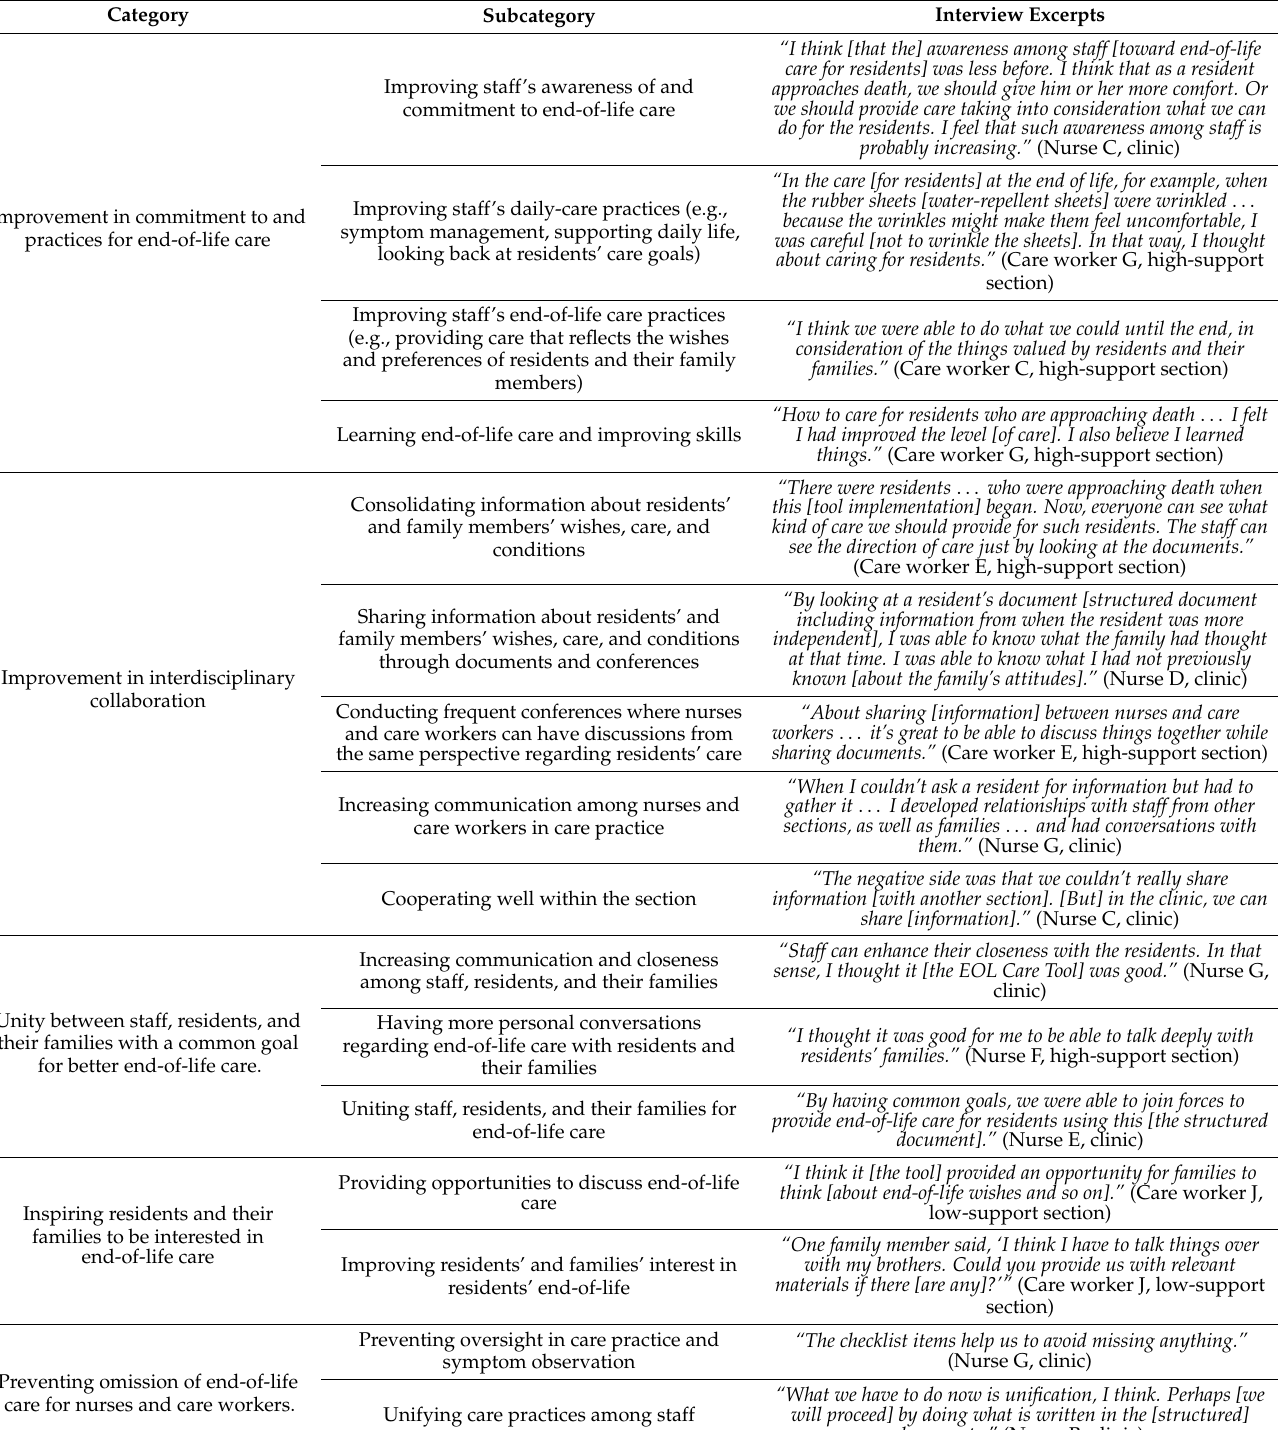
Table A1. Categories and interview excerpts: Nurses’ and care workers’ perceptions of the EOL Care